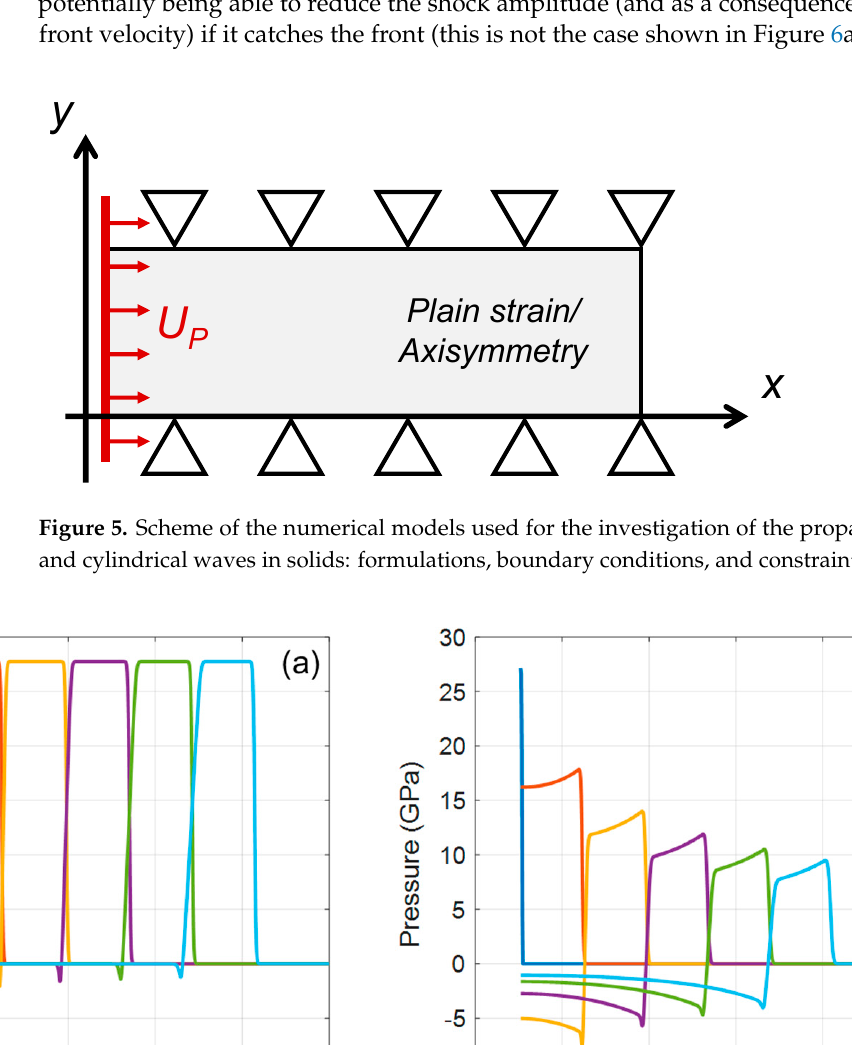
8 of 21 Figure 3. Pressure profile in case of plate impact: in function of time ( left ) and spatial coordinate ( right ). P ,  , E , C , and U p identify respectively pressure, density, energy, speed of sound, and particle velocity of a point belonging to the shocked material; P 0 ,  0 , E 0 , C 0 , and U p 0 identify pressure, density, energy, speed of sound, and particle velocity in the undisturbed material, respectively; U s is the shock front velocity with C + U p > U s . Figure 4. Explanation of the formation of a shock front starting from a smooth wave beyond the elastic limit; at each point, the velocity of the pressure wave is the sum of the speed of sound and the particle velocity proper of the conditions in which the point is ( C C + U p C > C B + U p B > C A + U p A ). The high energy deposition inside the material produces a loading condition for which the cylindrical assumption is more realistic. At the beginning of these phenomena, the spatial pressure distribution is strictly related to the energy distribution deposited in the material (Figure 1). During the subsequent phase of propagation, the shockwaves gen ‐ erated in the material maintain an axisymmetric shape. This introduces some peculiarities that differentiate the wave propagation from those expected for the planar case (Figure 3). The scope of the present study is to analyze the results obtained from the numerical sim ‐ ulations of the high ‐ energy impact with reference to what is expected from the wave prop ‐ agation for cylindrical waves and underlying the differences with the more common me ‐ chanical impact scenarios. The rigorous mathematical solutions of the partial differential equations governing the propagation of planar and cylindrical waves are not presented here for sake of brevity, but they can be found in [54]. Since the numerical approach is the basis of the present study, it was also applied for this preliminary investigation. To this end, two simple numerical models were built for the visualization of the differences be ‐ tween planar and cylindrical shocks (Figure 5). The finite element simulations were per ‐ formed with the software LS ‐ DYNA. For the planar case, the geometry was modeled with shell elements in plain strain formulation and the uniaxial strain condition was obtained by fixing the nodes to not move in the y direction; in this way, the lateral deformation was prevented. In the cylindrical model, the geometry was modeled with shell elements with